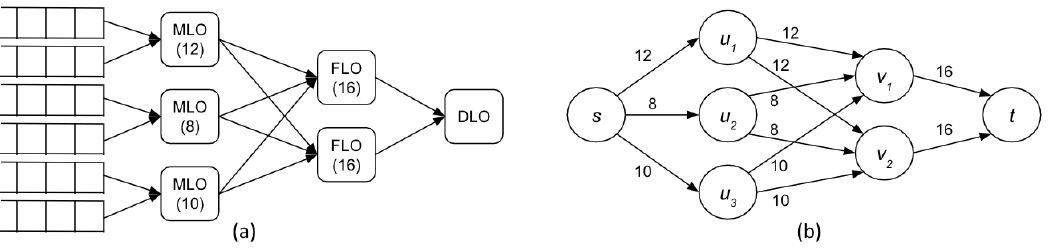
Figure 5. ( a ) Example scenario for nodes allocation. ( b ) Flow graph with edge capacities in